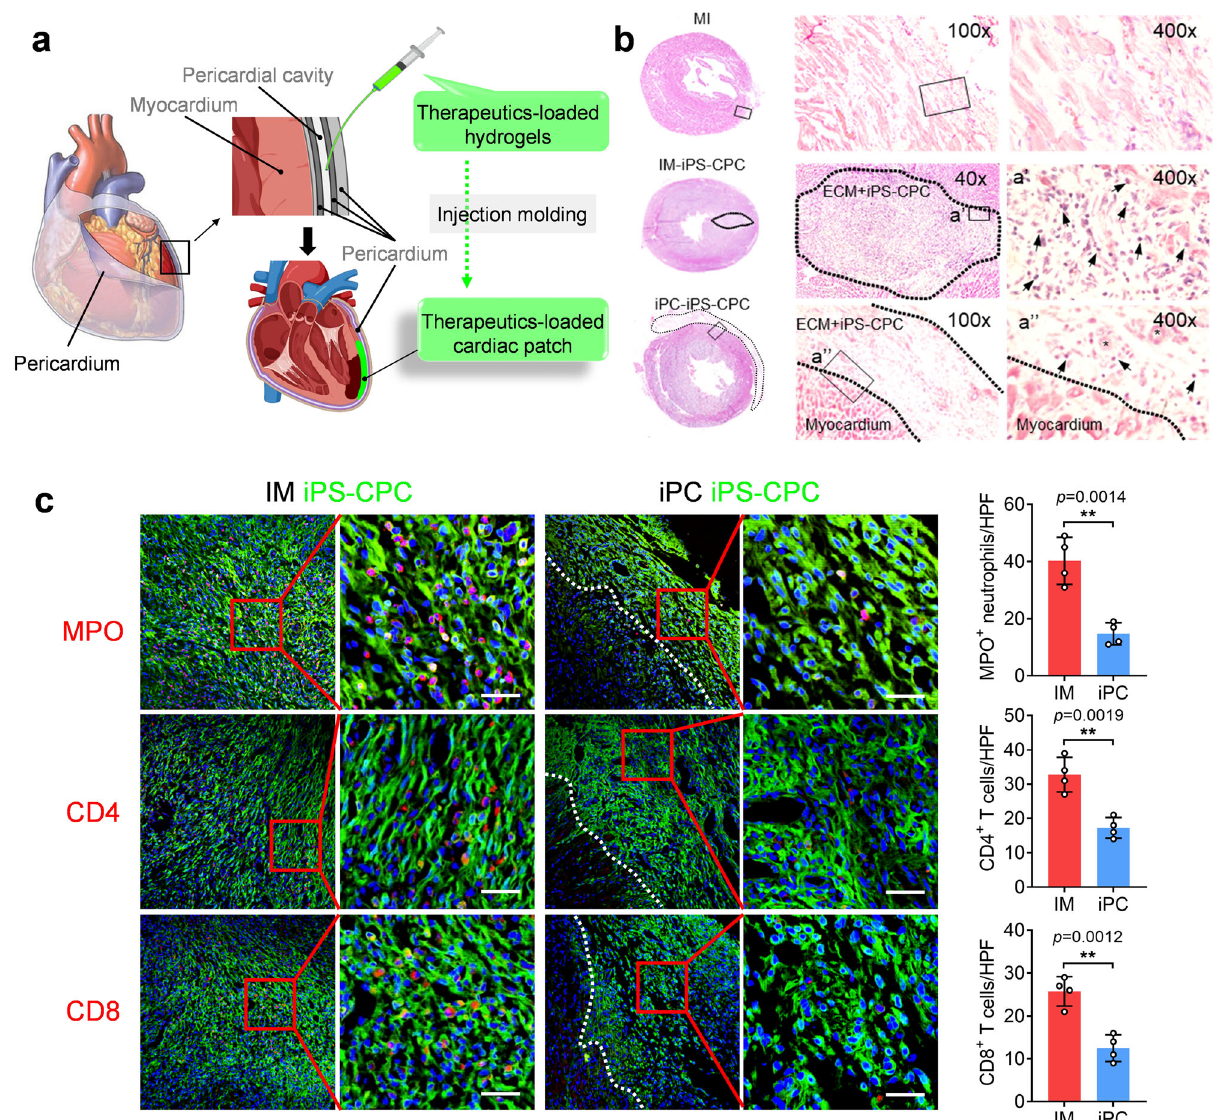
Fig. 1 iPC injection mitigates immune response as compared to IM injection in rats. a Schematic illustration of iPC injection and in situ formation of cardiac patch. b H&E staining showing the formation of a cardiac patch 7 days after iPC injection in the iPC-iPS-CPC group (dash lines delineate the injected cells). Intramyocardial (IM) injection of iPS-CPCs in ECM hydrogel caused massive in fi ltration of immune cells (arrows). iPC injection reduced immune cell in fi ltration and promoted regional formation of blood vessels (asterisks) in the patch. c Representative microscopic images showing the presence of neutrophils, CD4 and CD8 T cells, and corresponding quantitation. Scale bar, 60 μ m. Data were shown as mean ± SD, n = 4 animals per group. Comparison of two groups was performed with the unpaired, two-tailed Student ’ s t -test, ** p < 0.01. Source data are provided in a Source Data fi le. MI myocardial infarction, iPC intrapericardial injection, IM intramyocardium injection, iPS-CPC induced pluripotent stem cell-derived cardiac progenitor cell, ECM extracellular matrix, MPO myeloperoxidase, CD cluster of differentiation, HPF high-power fi